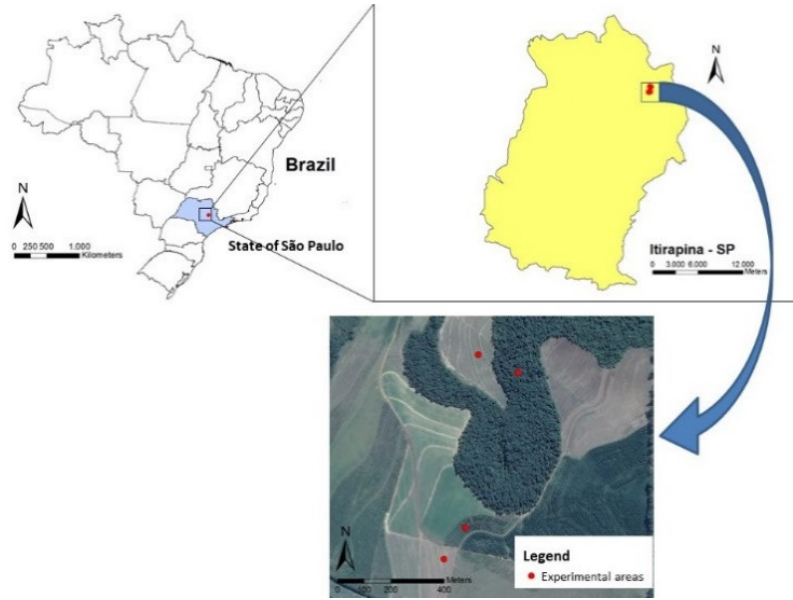
Figure 1. Location of experimental areas in the municipality of Itirapina, São Paulo, Brazil. Four land use systems were assessed: (i) agroforestry system developed for livestock (AFS1), (ii) the agroforestry system developed for fruit culture (AFS2), (iii) area used as pasture (Pasture), and (iv) forest fragment undergoing natural regeneration process (Forest). All land use systems were comprised under the same type of soil—classified as Neossolo Quartzar ê nico according to the Brazilian Soil Classification System [14]—with a sandy texture corresponding to the Entisols Quartzipsamments according to the Soil Taxonomy [15]. Table 1 presents the granulometry performed in June 2016 to characterize the soil texture areas. Table 1. Granulometric composition of experimental areas under different land use systems located in the municipality of Itirapina, São Paulo, Brazil.